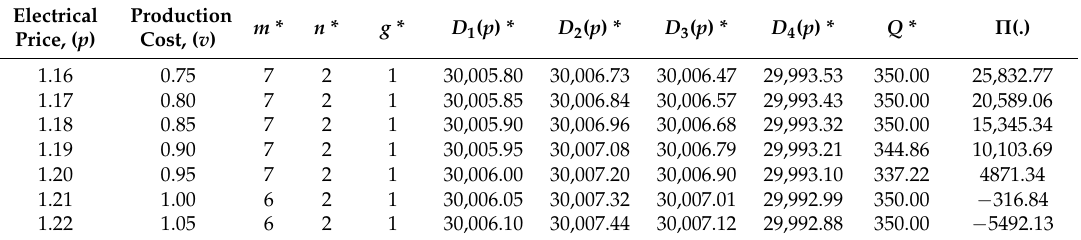
Figure 8. The Effect of Simultaneous Changes in the Price of Electricity and Production Cost on Profitand Demand. Table 12. Effect of Changes in the Price of Electricity and Production Cost